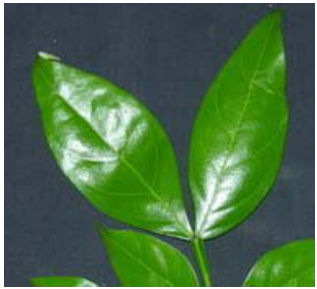
Figure 2. Inga Marginata leaves [37].